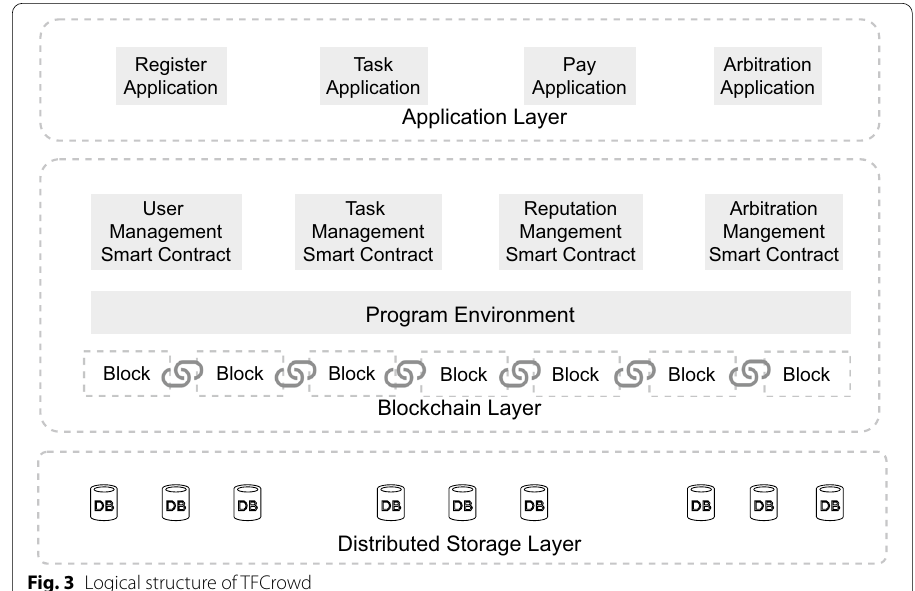
Fig. 3 Logical structure of